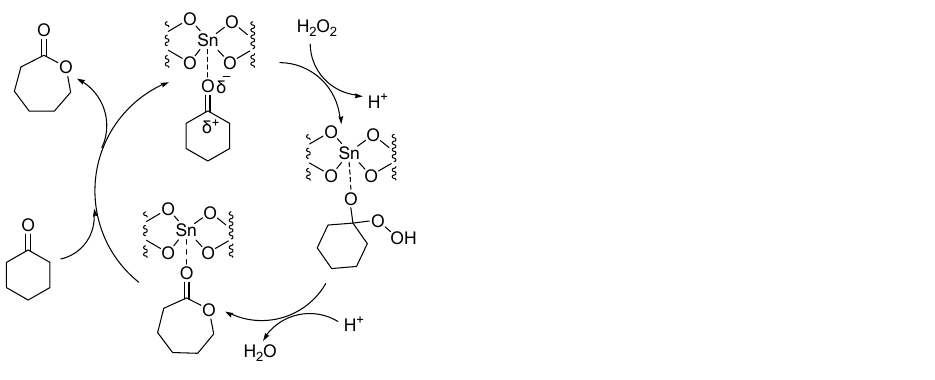
Figure 3. Mechanism of BV reaction catalyzed by Sn-zeolite beta using aqueous hydrogen peroxide as oxidant [36].